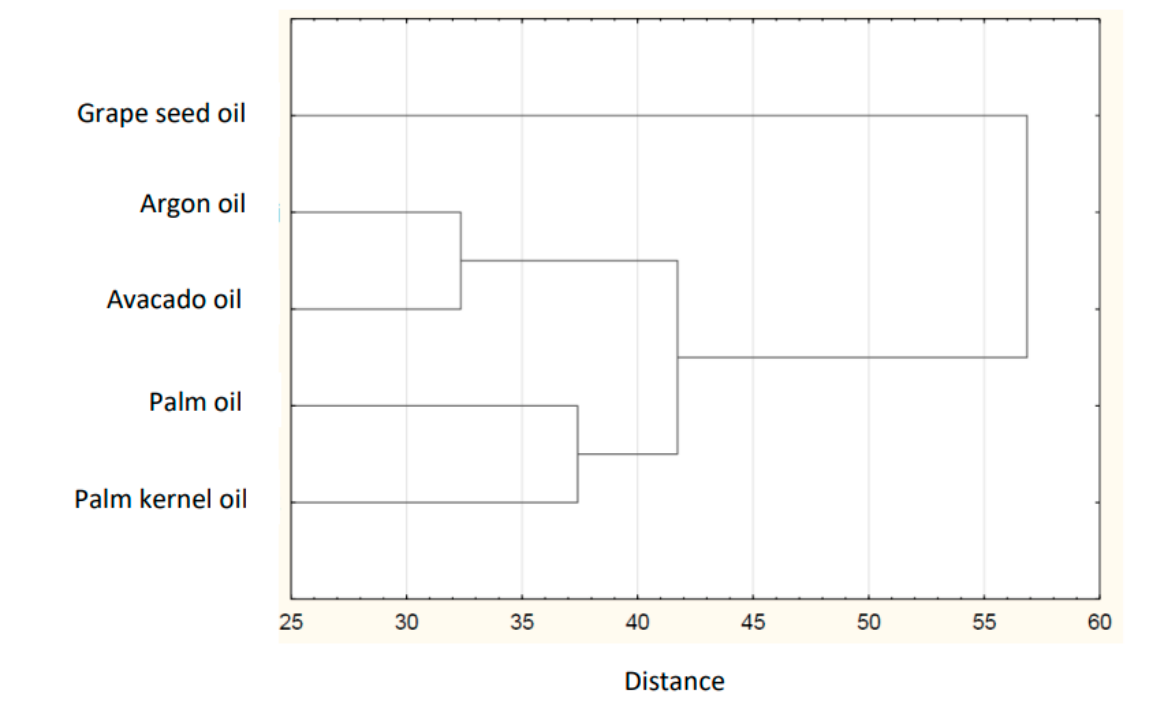
Figure 5. Hierarchical cluster graph of tropical fats and oils.